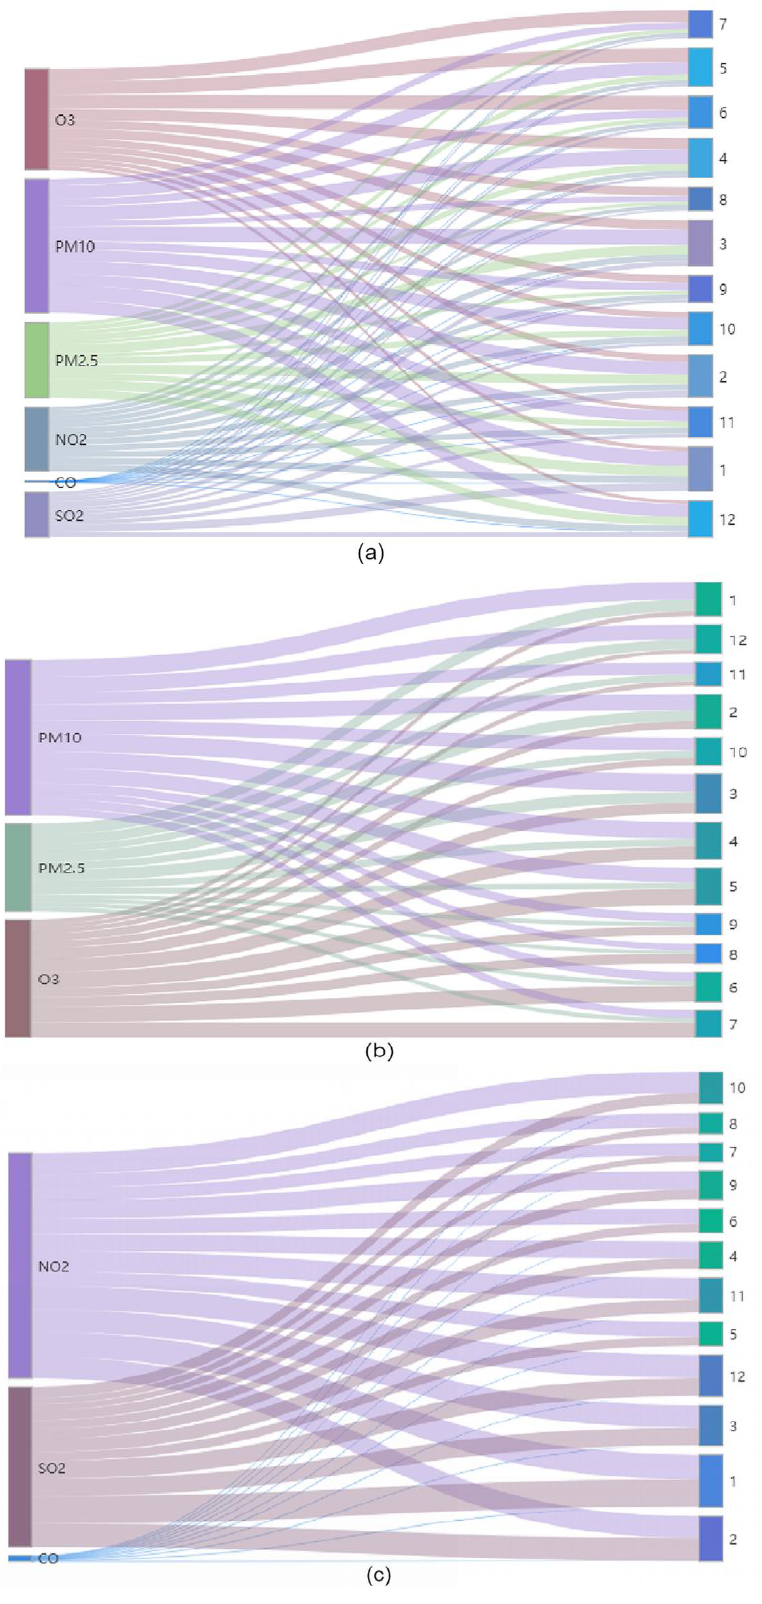
Figure 5. Monthly changes in concentrations of the six pollutants from 2017 to 2019: ( a ) CO, SO 2 , NO 2 , PM 2.5 , O 3 , PM 10 , ( b ) PM 2.5 , O 3 , PM 10 , ( c ) CO, SO 2 , NO 2 .